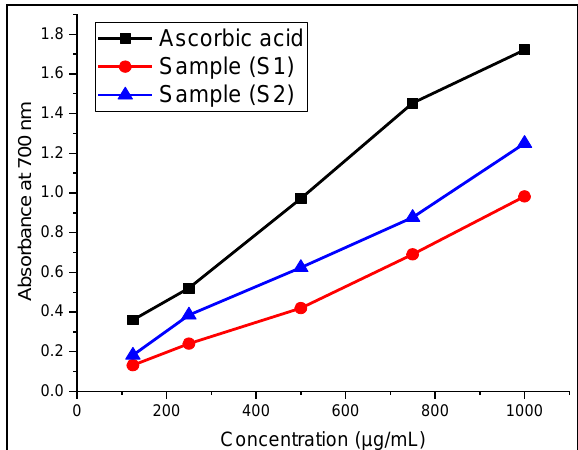
Figure 5. Ferric-reducing antioxidant power of O. majorana EO (S 1 and S 2 ) and standard reference (ascorbic acid) ( n = 3).